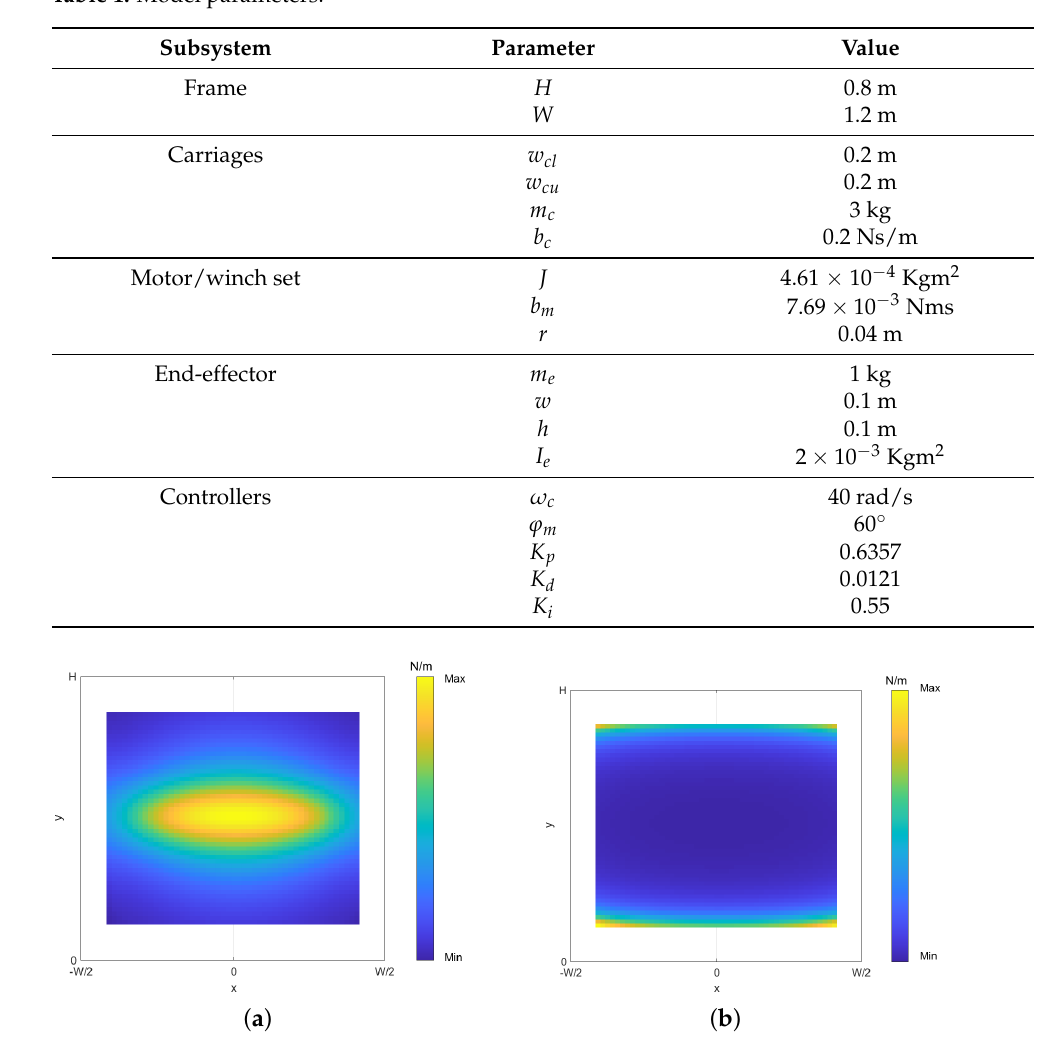
Figure 4. X axis stiffness comparison. ( a ) Conventional scheme; ( b ) new